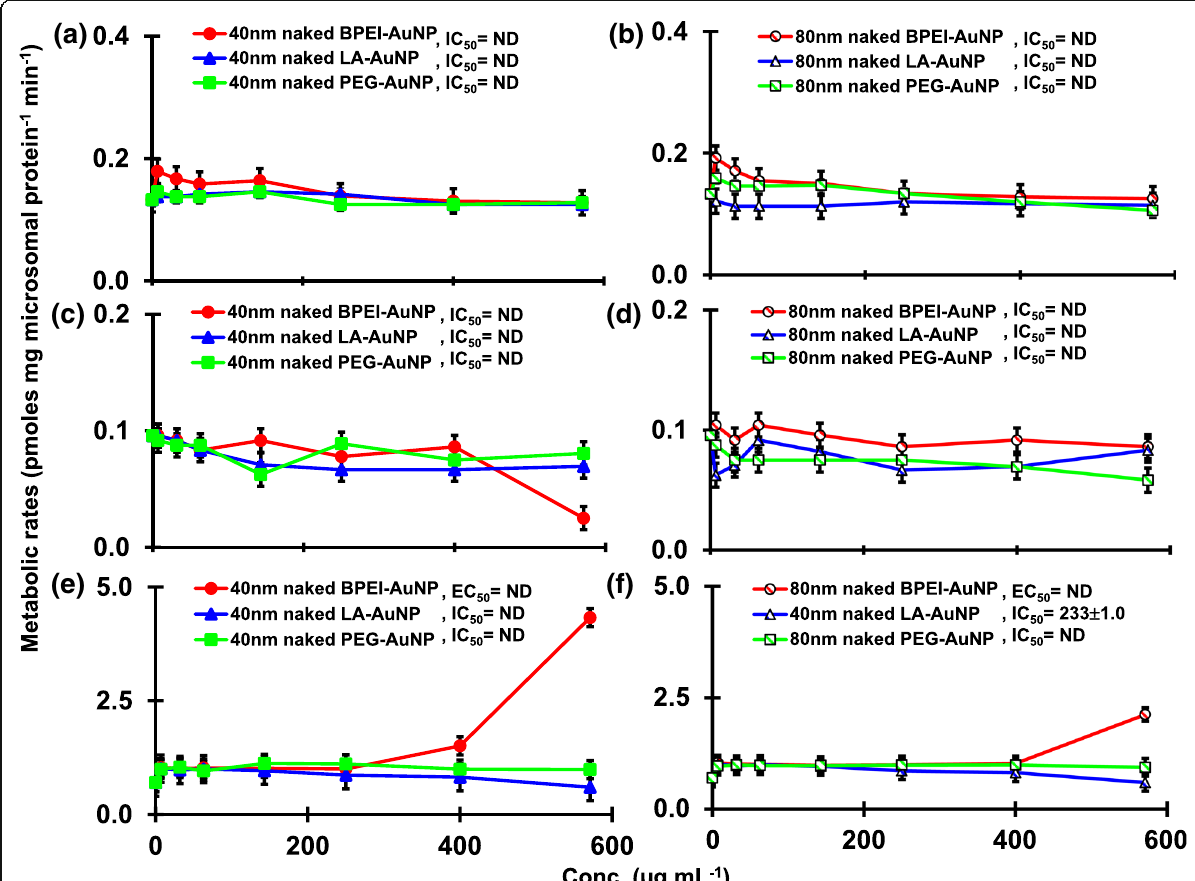
Fig. 4 An inhibitory and stimulatory effect of naked (no PC) AuNP on the production of 16 β -OH TST ( a , b ), 16 β -OH TST ( c , d ) and AD ( e , f ) in pHLM. Data represent mean ± S.D. ( n =3). IC 50 , half maximal inhibitory conc.; EC 50 , half maximal activation conc.; pHLM , pooled human liver microsomes; ND , not determined by fitting a Hill equation with variable slope to the observed data using GraphPad Prism®; PC , human plasma protein; BPEI , branched polyethylenimine; LA , lipoic acid; PEG , polyethylene glycol; Conc, concentration; 16 α -OH TST, 16 α -hydroxytestosterone; 16 β - OH TST, 16 β -hydroxytestosterone; AD ,